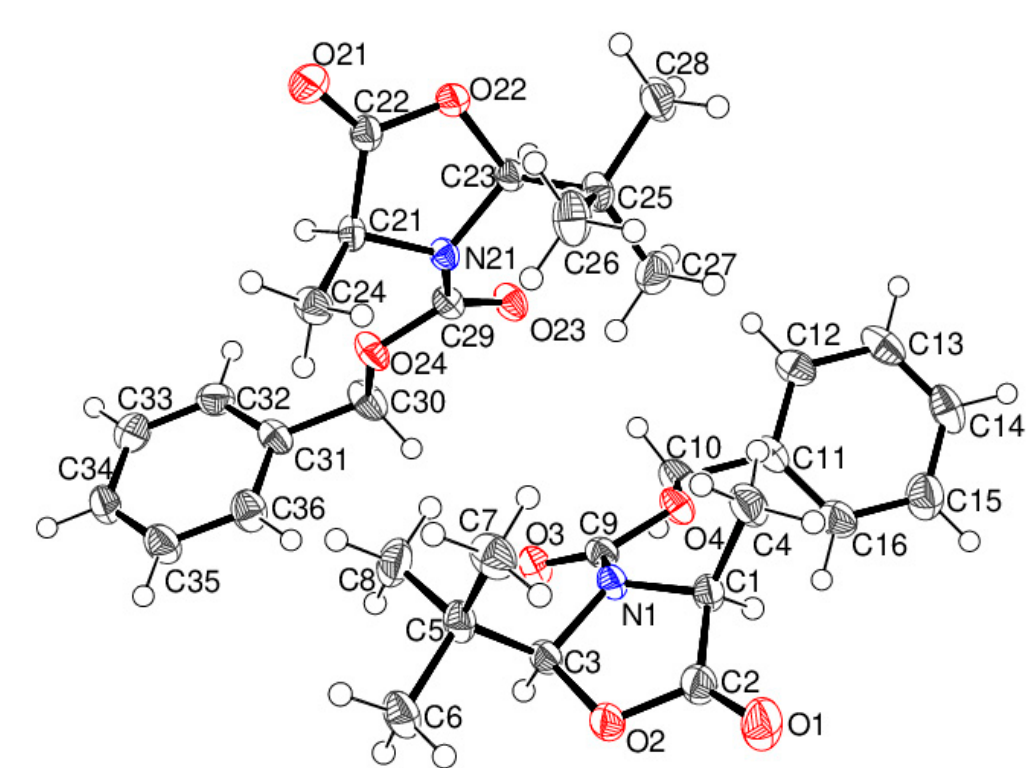
Figure 3. The asymmetric unit of ( III ) showing 50% displacement Figure 3. the asymmetric unit of ( III ) showing 50% displacement ellipsoids.